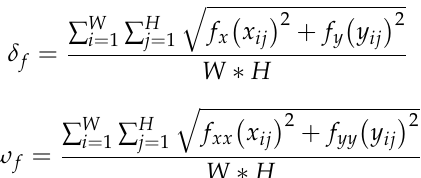
Figure 4. Experimental set-up [29]. The parameters of the macro- and micro-cameras used in the proposed measurement system are shown in Table 2.